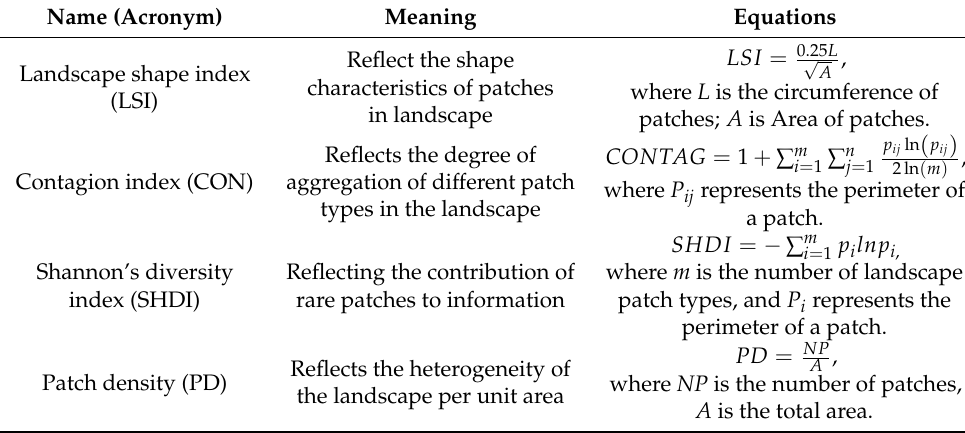
Table 2. Description of selected landscape metrics at the landscape